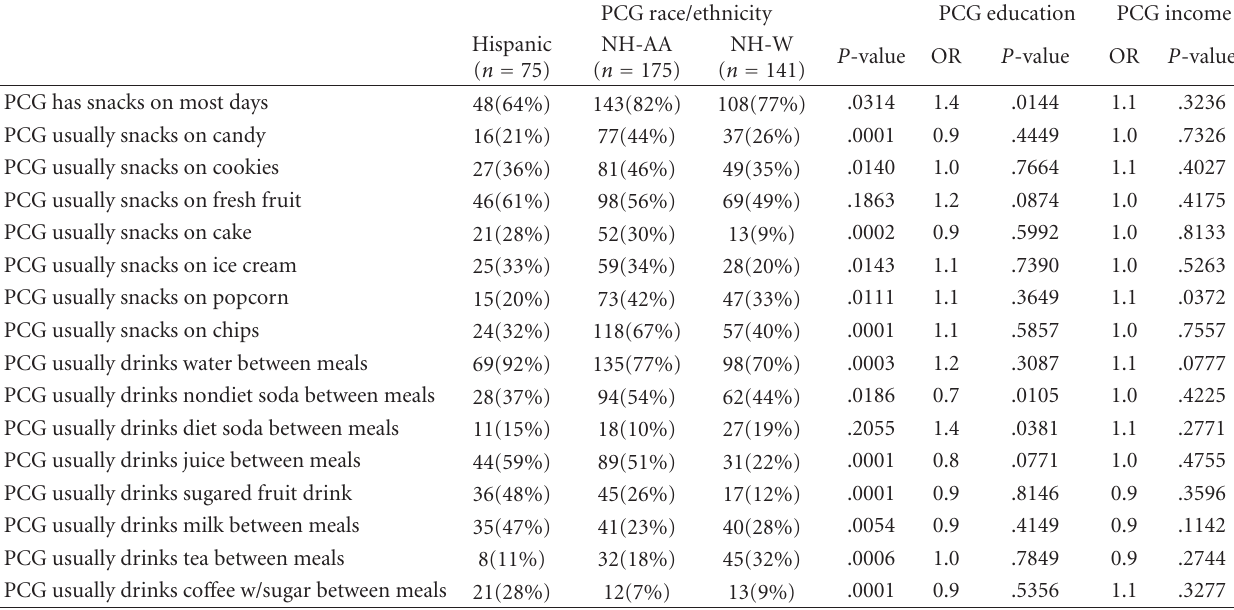
Table 4: Relationships of race/ethnicity, education, and income with questionnaire responses for snacking and drinking habits of the primary caregiver (PCG). Analyses were performed for each questionnaire item (items 80 through 82—see the appendix for questionnaire) using multivariable logistic regression models with race/ethnicity, income, and education as predictors. Race/ethnicity P -values are for the overall test of any di ff erence among the three groups. N (%) for Race/Ethnicity, Odds Ratio (OR) for education and income. NH-AA = Non-Hispanic African-American, NH-W = Non-Hispanic